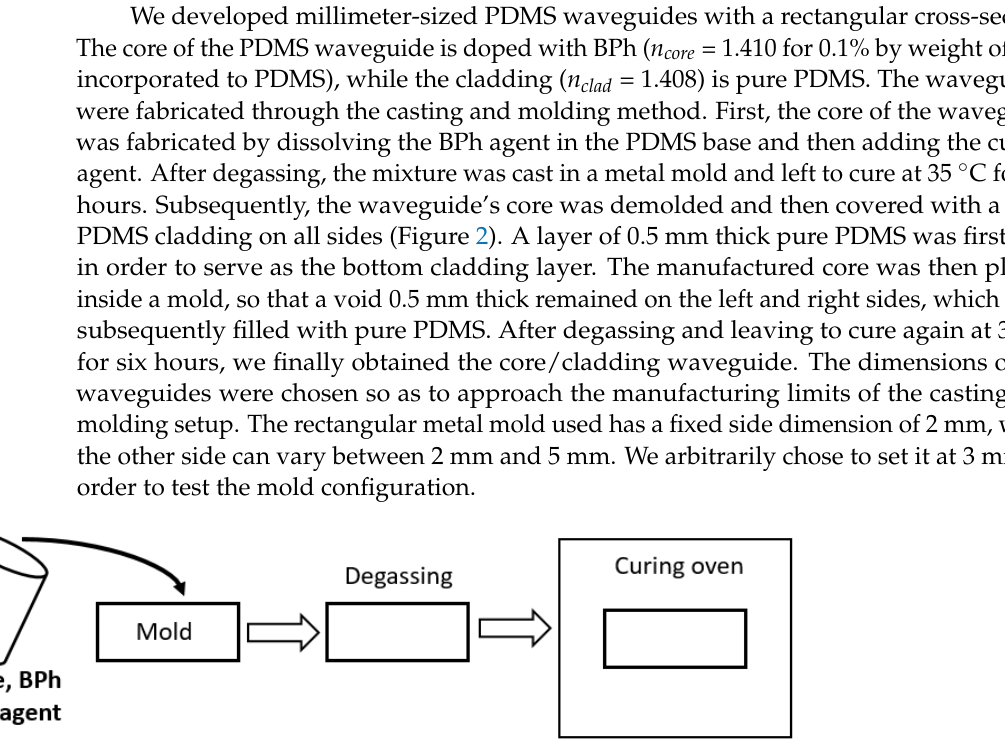
wt.%. Solid lines represent the fitting model of Equation (2).